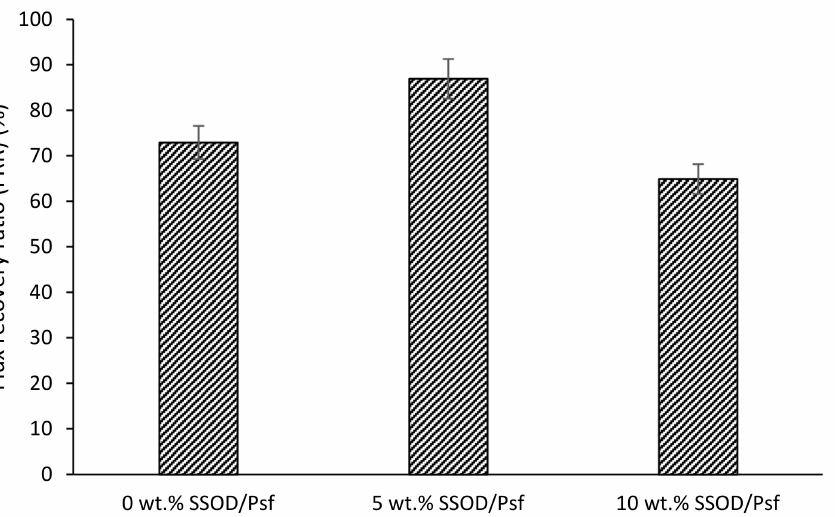
Figure 11. Flux recovery ratio of SSOD/Psf (0–10 wt.%) membranes. Experimental conditions: temperature: 25 ◦ C; Pressure: 4 bar.